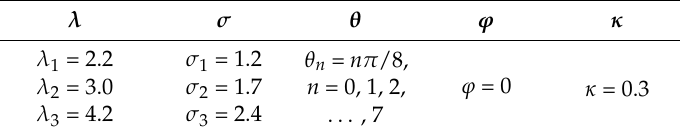
Table 1. Parameter setting for Gabor wavelets.